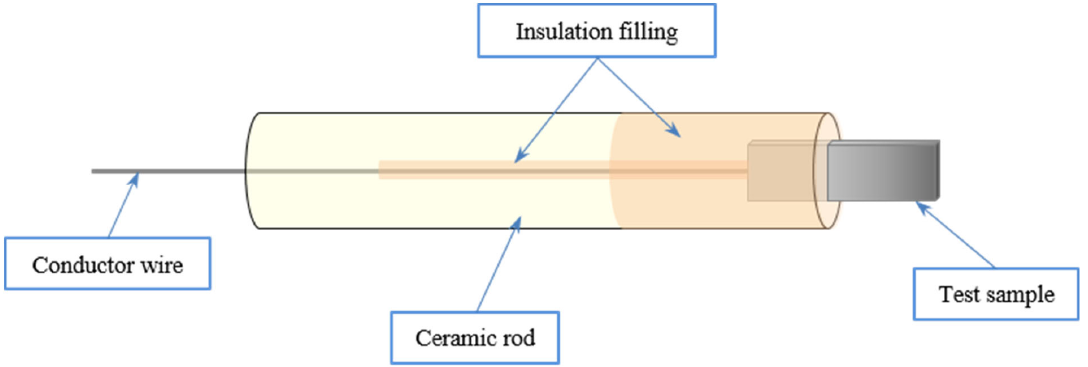
Figure 1. Sketch of an electrode used in the electrochemical sensor.